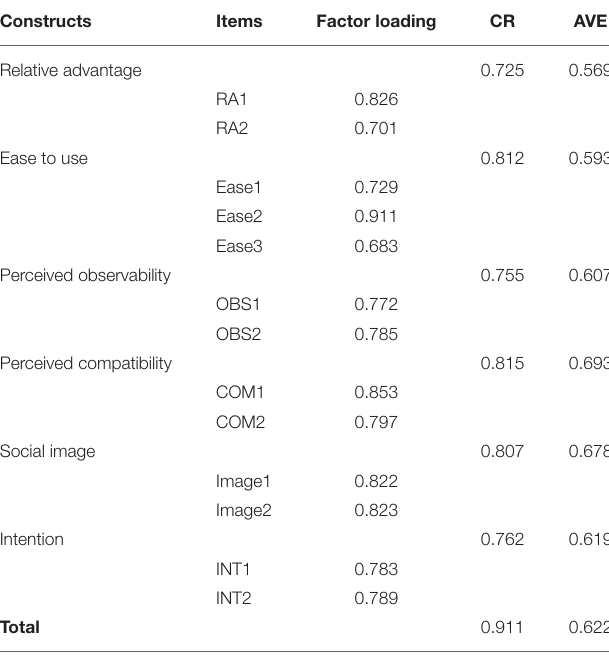
TABLE 2 | Demographic characteristics of the participants. TABLE 3 | Confirmatory factor analysis results of the measurement